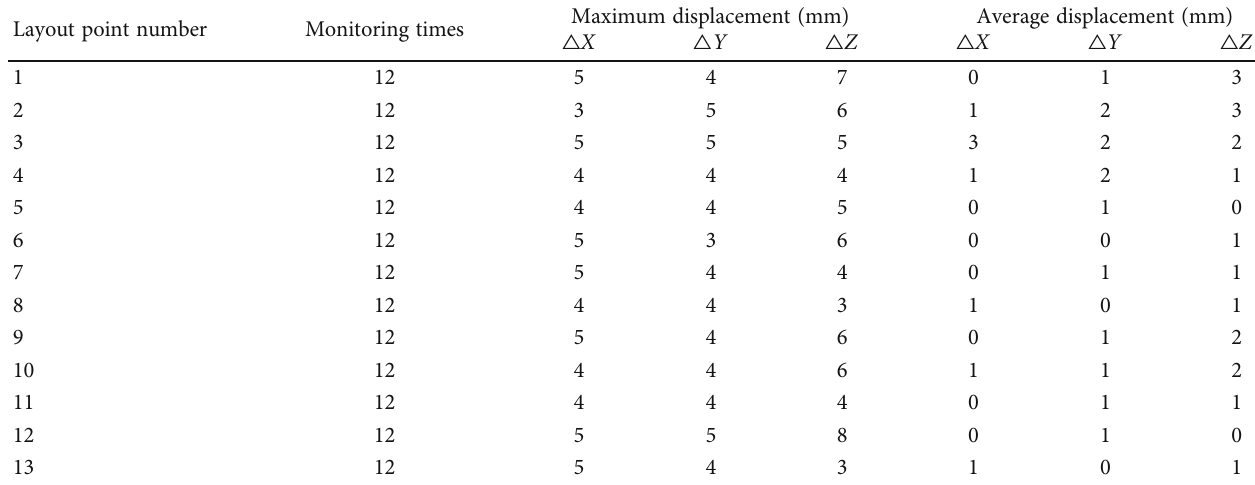
Table 6: Horizontal and vertical displacement